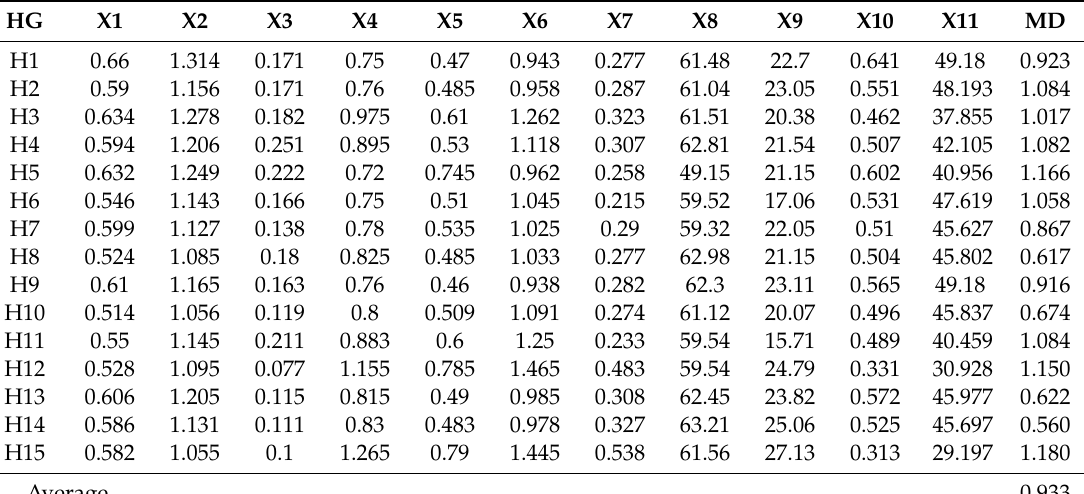
Table 6. MD of the healthy group (HG) data